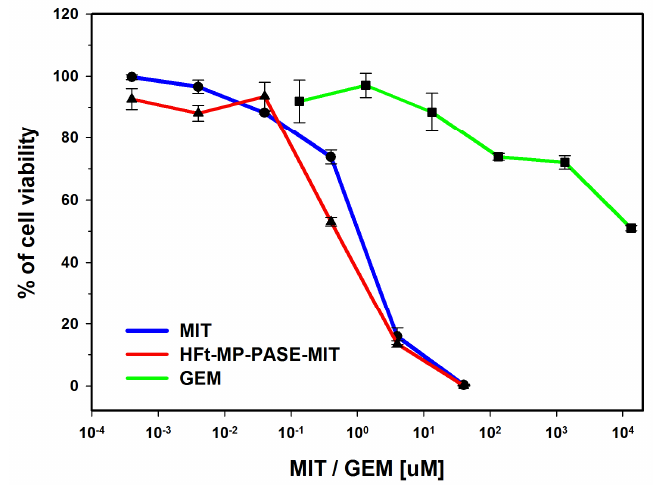
Figure 1. Cytotoxic potential of free or loaded-MIT using XTT assay. PaCa44 pancreatic tumor cells were treated 48 h with serial dilution of HFt-MP-PASE-MIT, MIT or GEM. The percentage of cell viability was measured by XTT assay, and means ± SEM were calculated from three independent experiments.